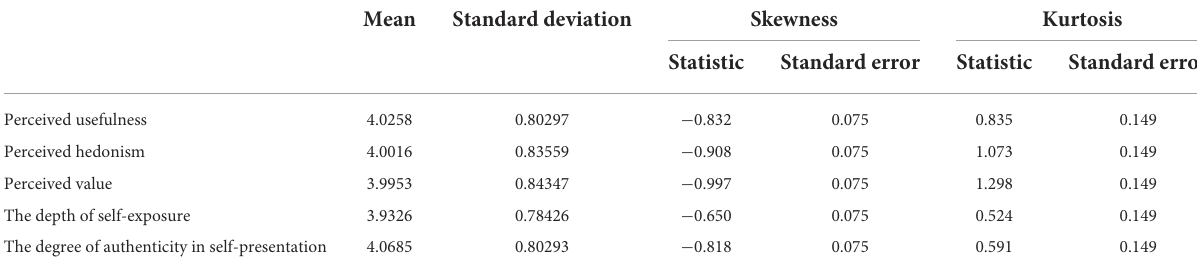
TABLE 3 A description of the normality of statistics ( N =